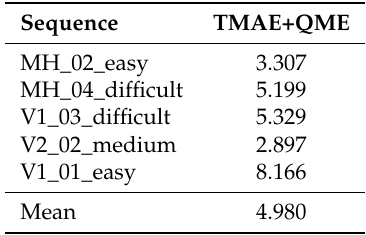
Table 5. Trajectory RMSE in meters for the test sequences from EuRoC MAV dataset.